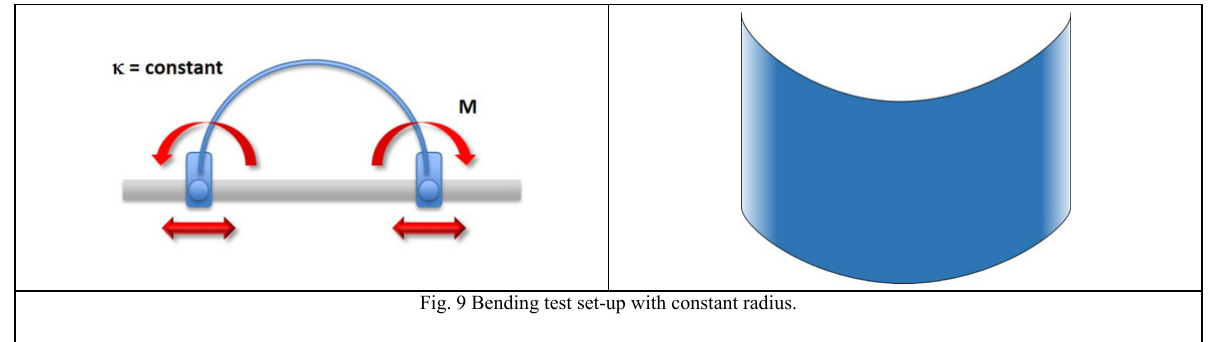
Fig. 9 Bending test set-up with constant